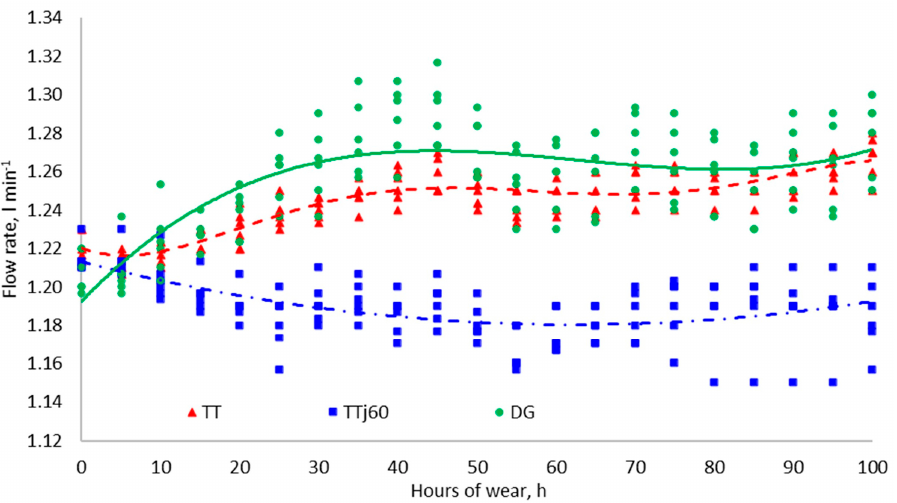
Figure 4. Flow rate at different wear intervals for the TT, TTj60, and DG nozzles. After analysis of the changes in nozzle structure with visual methods (Figure 5), it was not possible to notice changes in the dimensions of the nozzle orifice. It is worth men- tioning that these photos were taken for the pre-orifice from inside the nozzle body. It was not possible to take such photos for the final orifice from outside because of the geometry of these nozzles, especially the TT and TTj60 nozzles where the final orifice from outside is almost hidden.